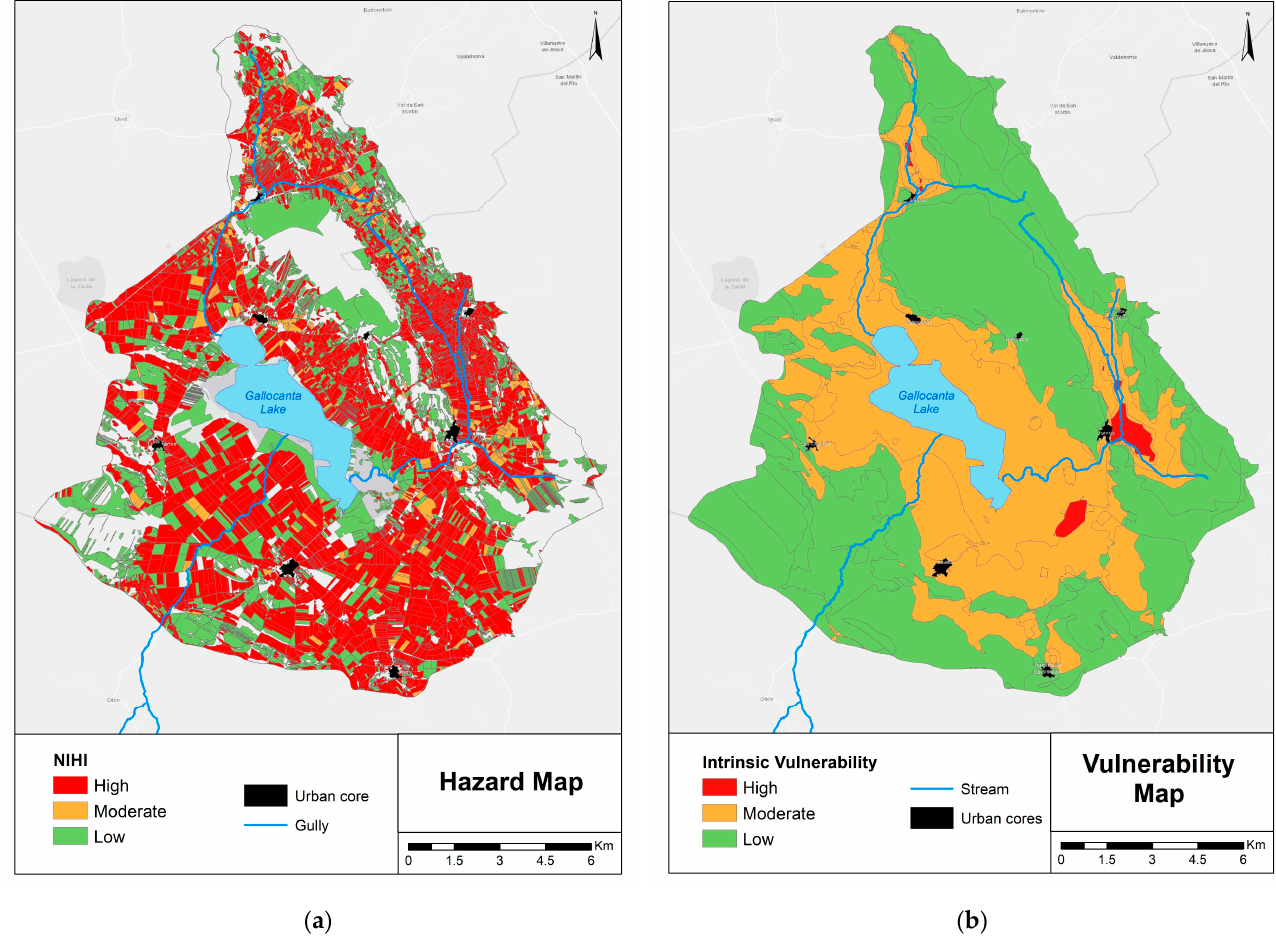
Figure 4. ( a ) Hazard map; ( b ) Intrinsic vulnerability map.